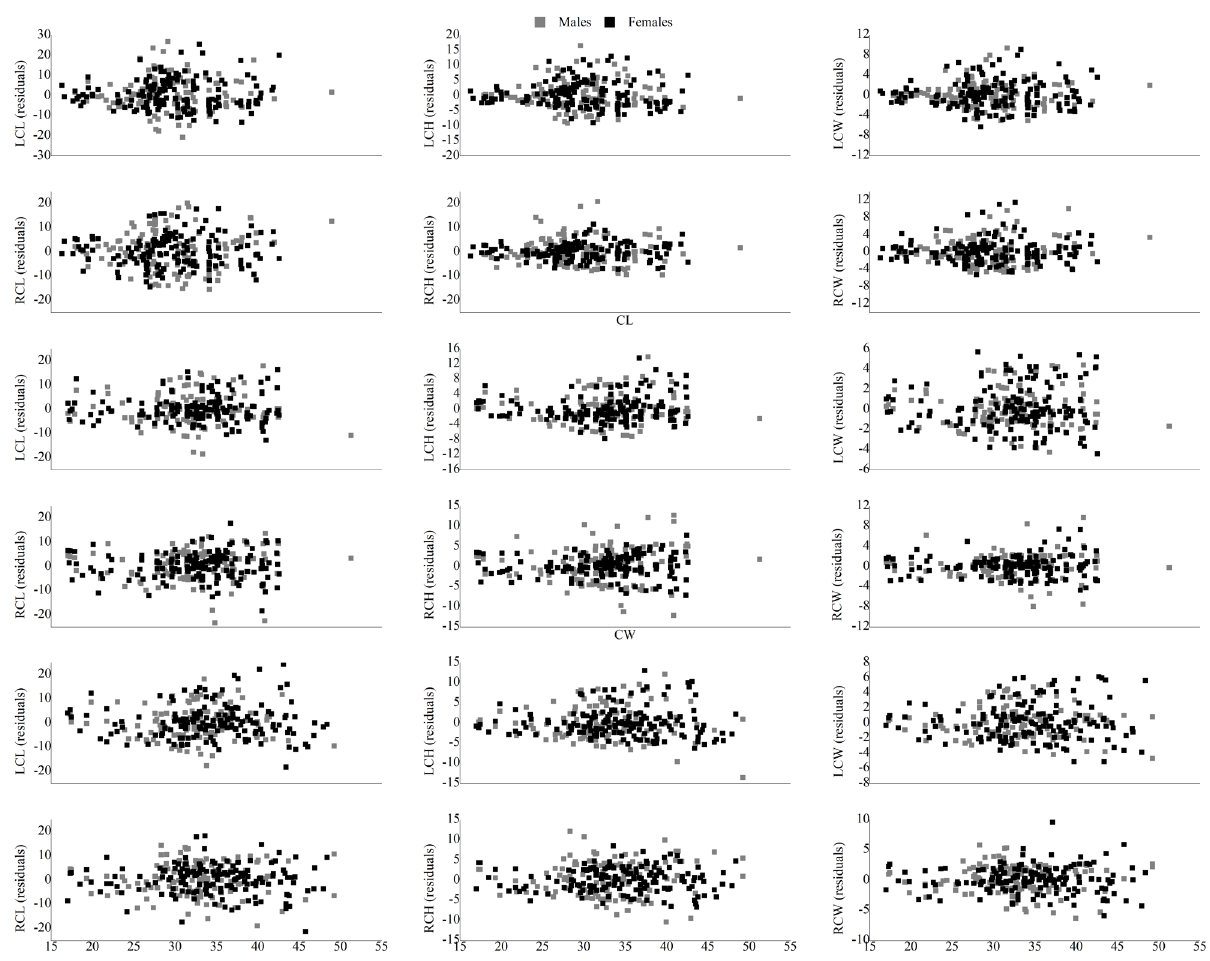
Figure 5. Residual values from the best models fitted to the morphometric data of Menippe frontalis in the Gulf of Guayaquil, Ecuador. CW, carapace width; CL, Carapace length; CH, carapace height; LCL, left chelae length; LCH, left chelae height; LCW, left chelae width; RCL, right chelae length; RCH, right chelae height; RCW, right chelae width.